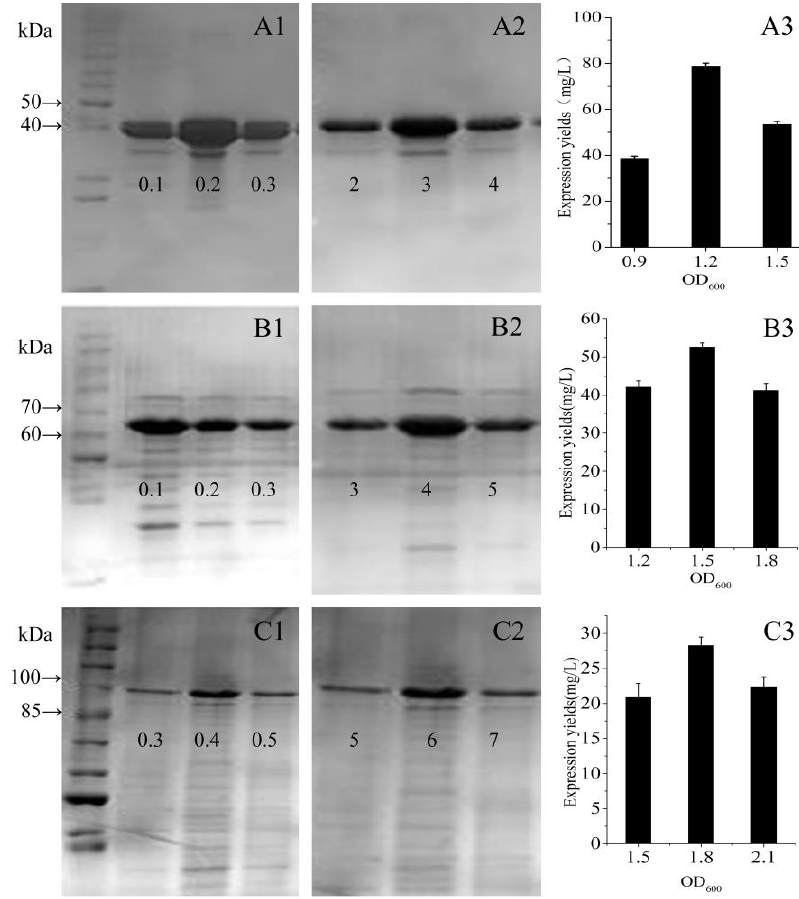
Figure 6. Expression level of each fusion protein by the three points method. ( A1 – A3) GST-GS16F1; ( B1 – B3 ) GST-GS16F4; and ( C1 – C3 ) GST-GS16F8. A1 - C1 : different IPTG concentration (mM); A2 – C2